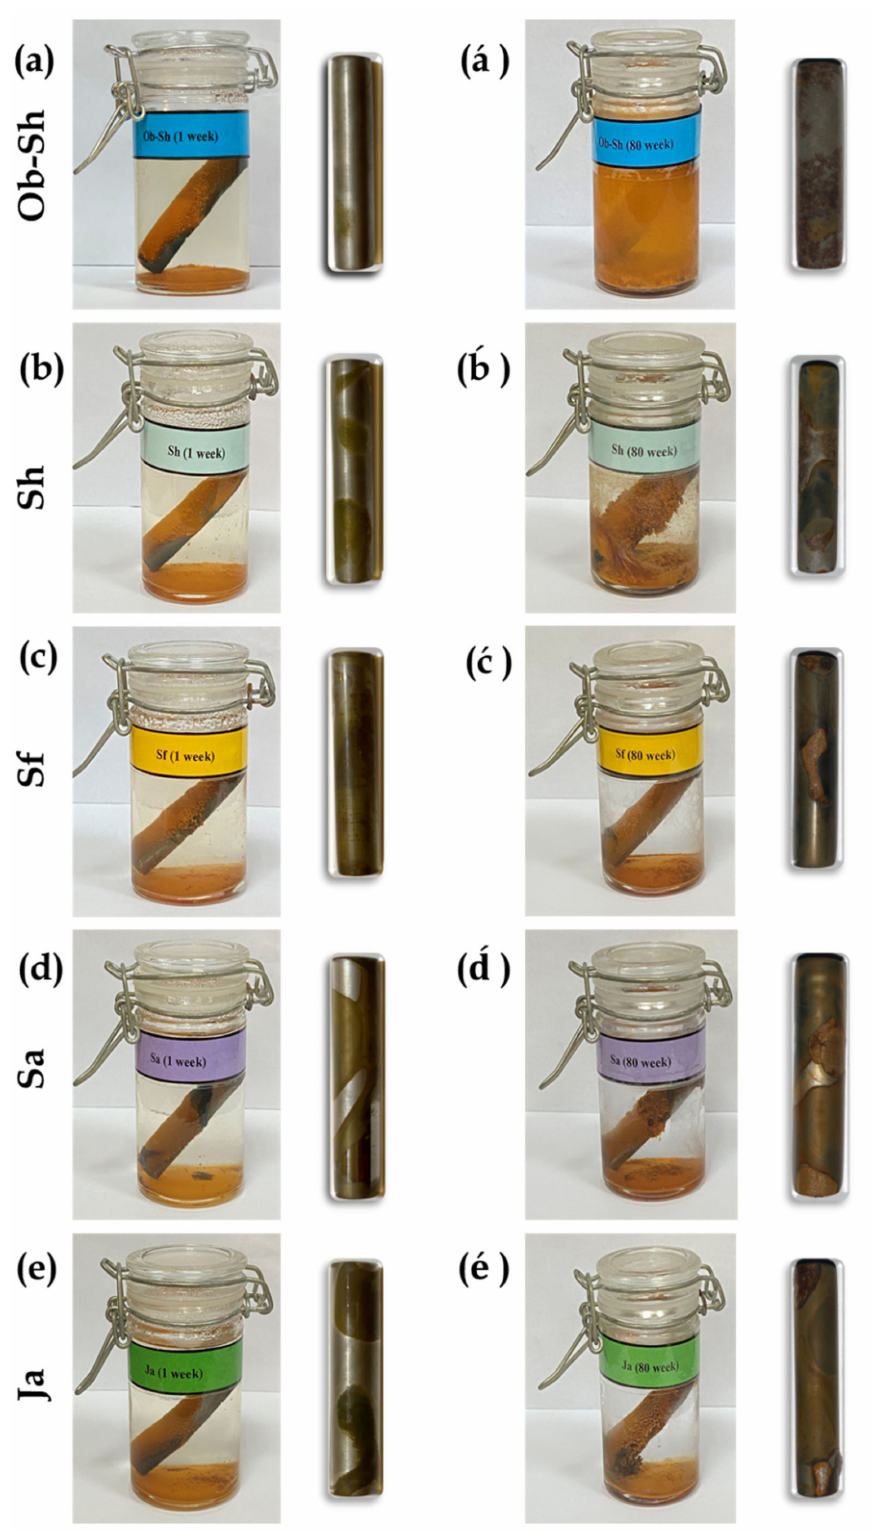
Figure 6. Optical images for the corrosion of CSX36 specimens over: ( a – e ) 1 week and ( á – é ) 80 weeks of immersion in the studied Jeddah soil solutions at 23 ± 1 ◦